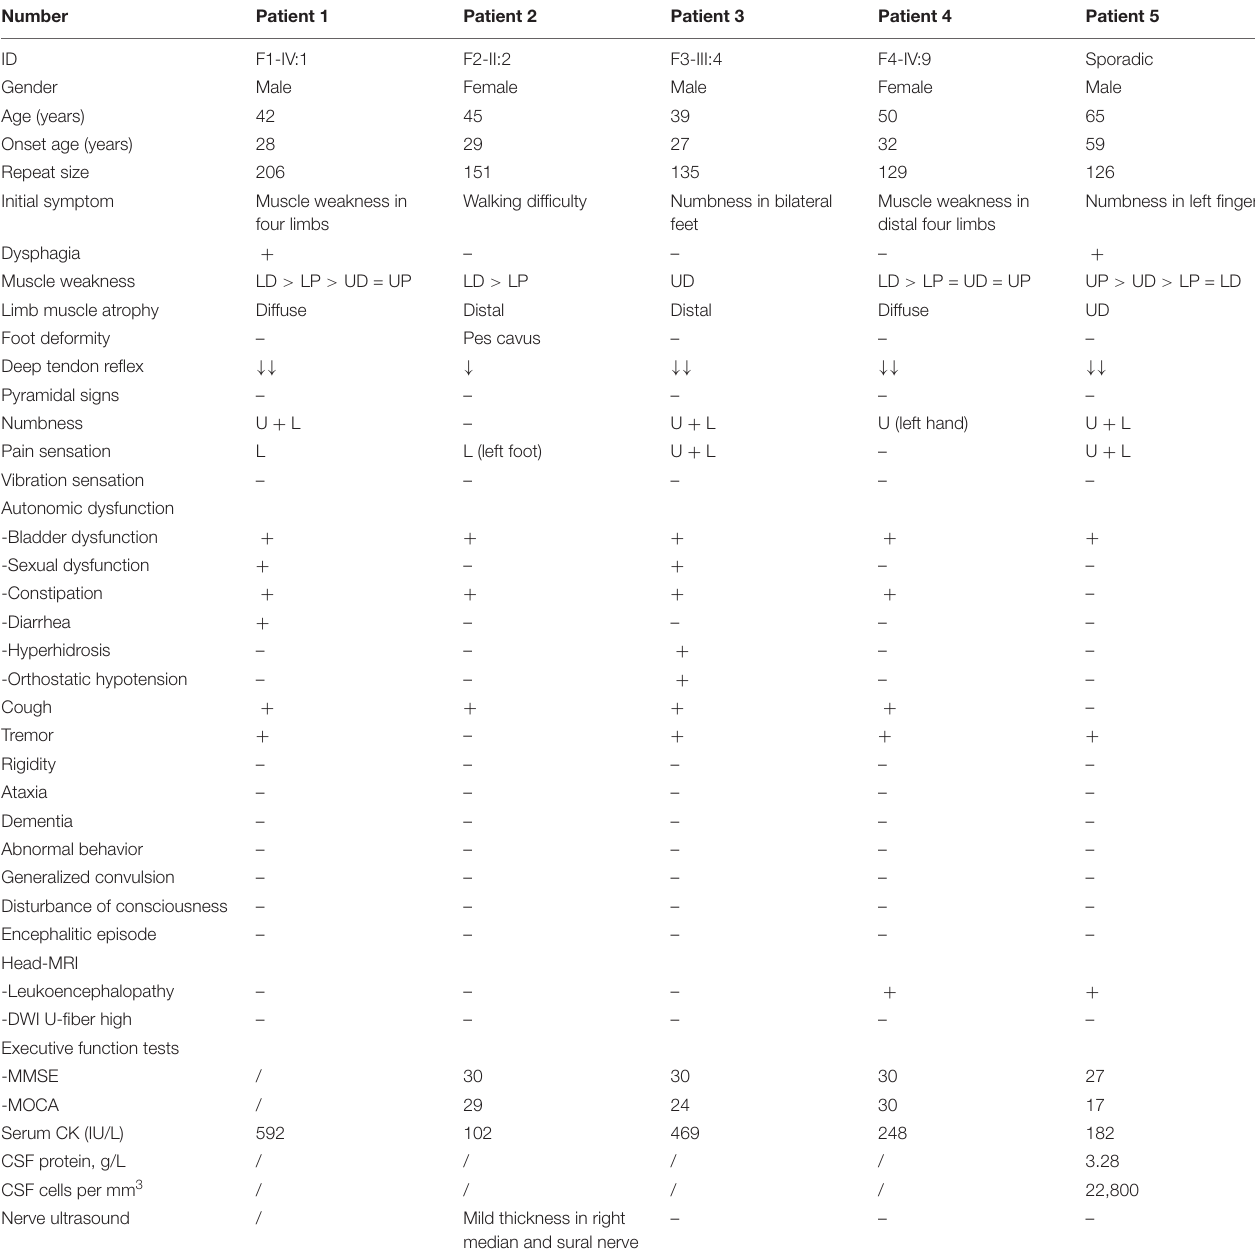
TABLE 1 | Clinical features of patients with abnormal GGC repeat